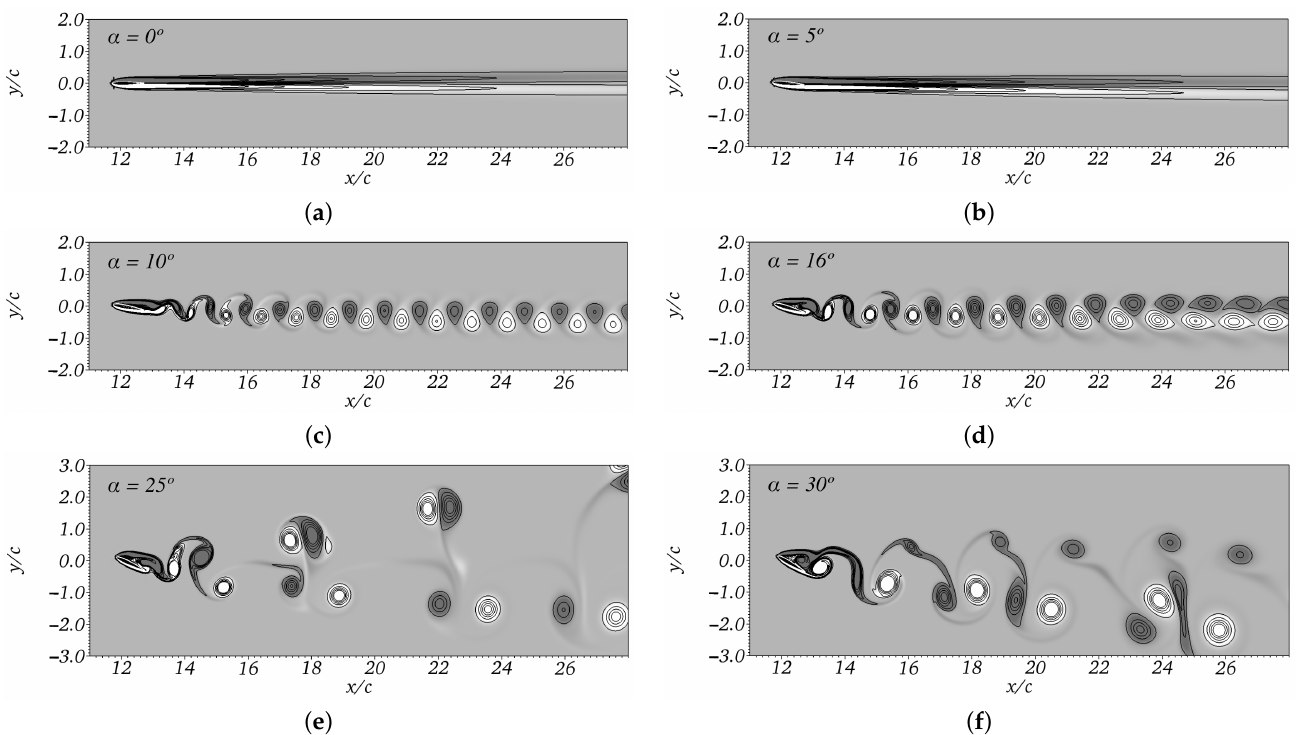
Figure 15. Instantaneous vorticity fields − 1 ≤ w z c / U 0 ≤ 1 over the NACA 0012 airfoil for different α values.